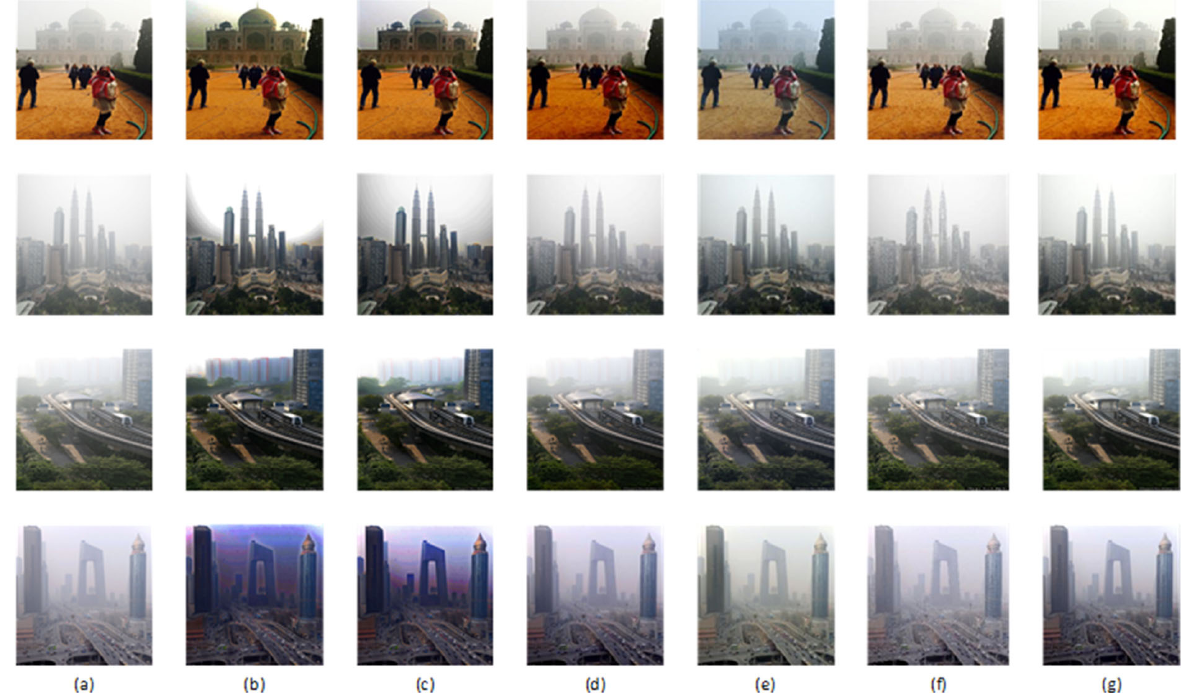
Figure 7. The experimental results of the real outdoor hazy images. ( a ) Hazy image; ( b ) method in [5];